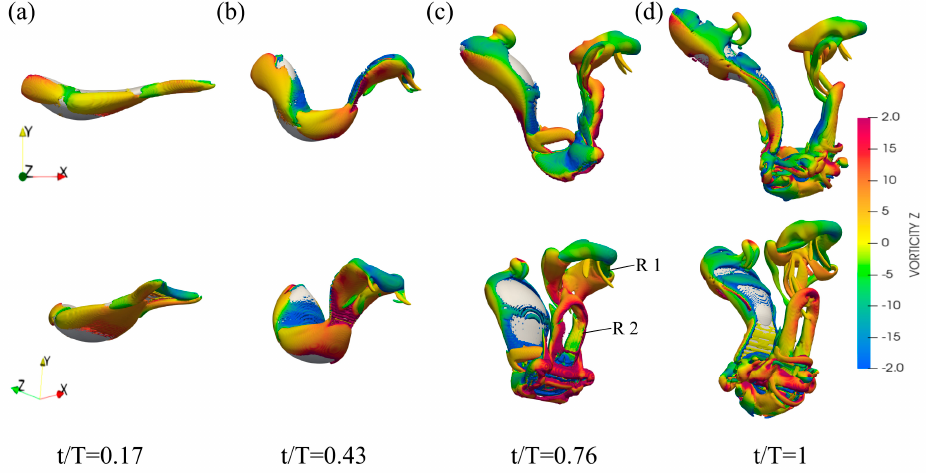
Figure 8. Three-dimensional vortex structures in the flow at four moments of different perspective. ( a ) t/T = 0.17. ( b ) t/T = 0.43, the moment of the end of stage 1. ( c ) t/T = 0.76, the moment of the end of stage 2. ( d ) t/T = 1, the last moment of the fast